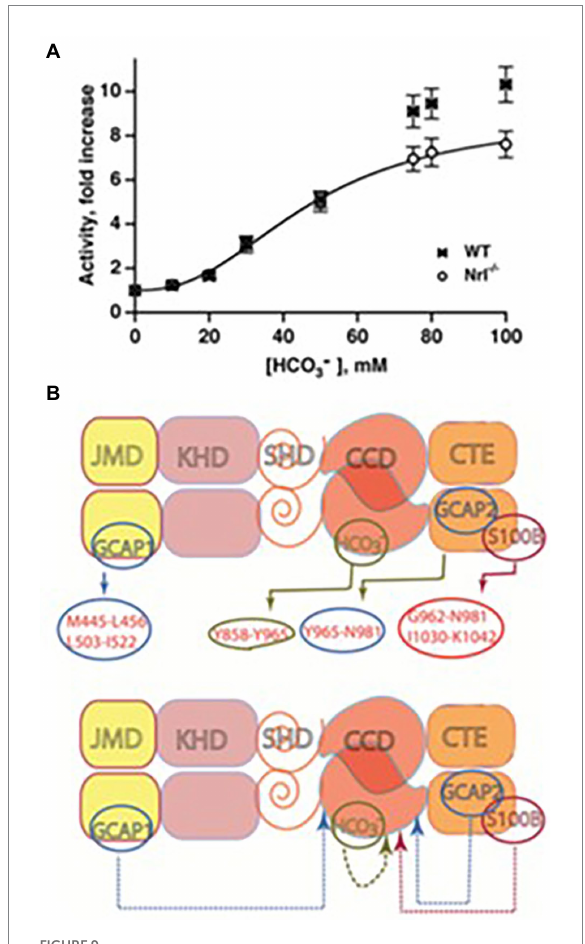
FIGURE 9 Bicarbonate modulation of ROS-GC activity. (A) Stimulation of ROS-GC in photoreceptor outer segment preparations from WT and neural retina leucine zipper transcription factor knock out (NRL − / − ) mice. NRL − / − photoreceptors express ROS-GC1 and GCAP1 exclusively. The dependence of guanylate cyclase activity on bicarbonate is cooperative with an EC 50 of 47 mM. The elevated activity at high bicarbonate concentration in WT outer segments is attributed to their additional expression of GCAP2. Error bars show SEM (Duda et al., 2015). (B) Ca 2+ -dependent and-independent modulators of ROS-GC1 activity. Upper panel: three Ca 2+ sensor proteins – GCAP1, GCAP2, and S100B – and one Ca 2+ -independent modulator, bicarbonate, target individually the indicated domains within the intracellular portion of ROS- GC1. Lower panel: the targeted domains are specific switches all of which signal activation of the catalytic domain. The signaling pathways are indicated as dashed